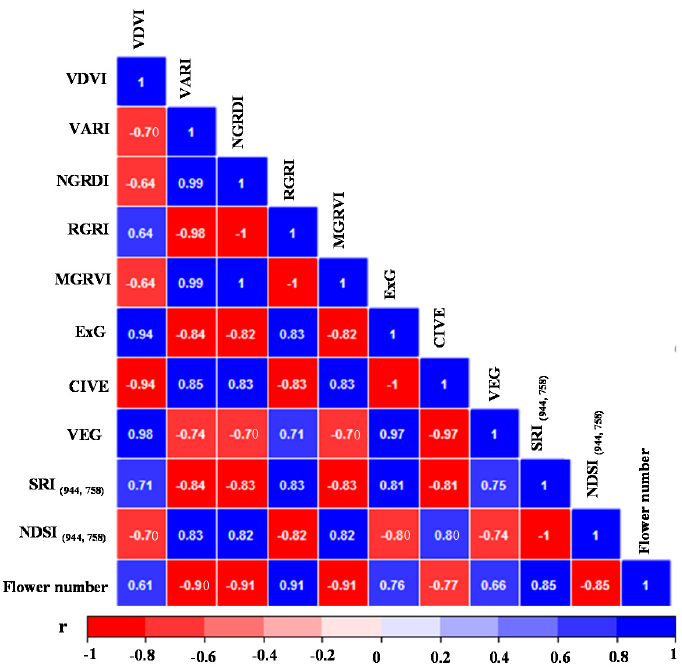
Figure 7. Correlation analyses (r) between UAV variables including vegetation indices (VIs) and flower coverage area (FCA) and ground-counted flower number of oilseed rape.